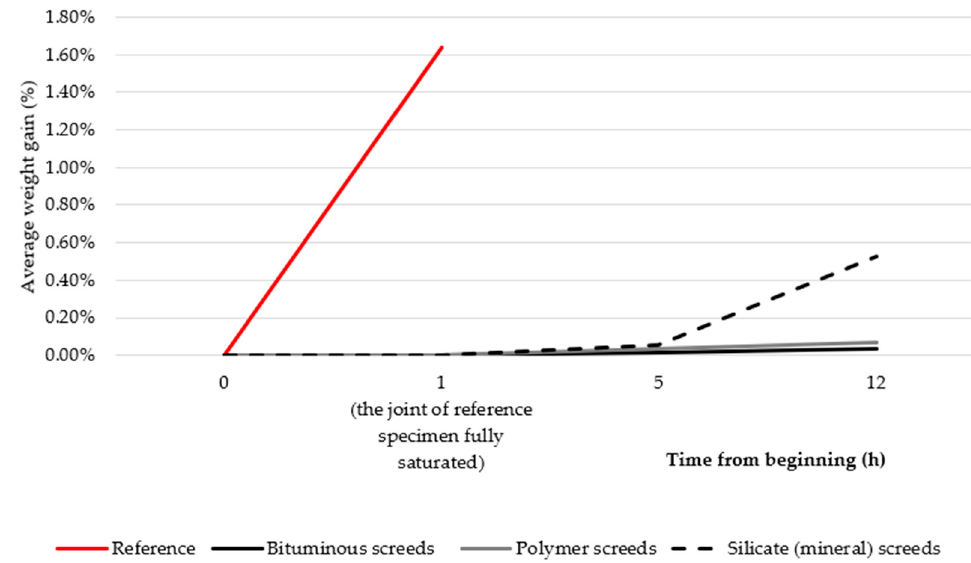
Figure 12. Change in weight during the time (in percentage).